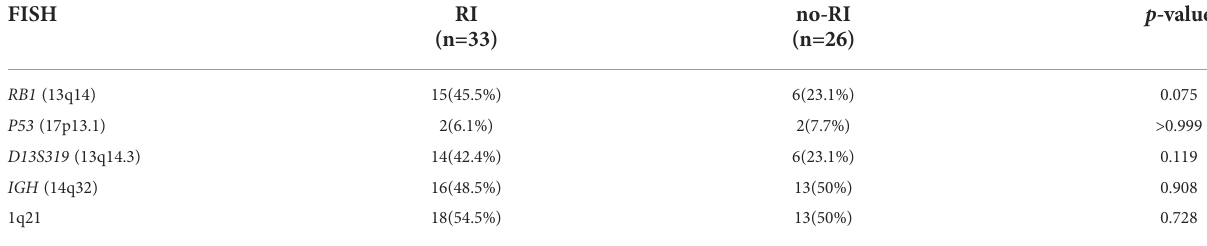
TABLE 3 Cytogenetic results of the RI and no-RI groups.